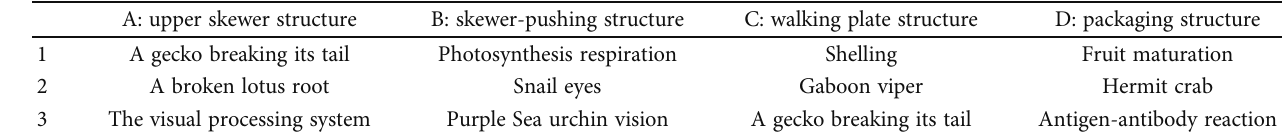
Table 3: The preliminary orthogonal